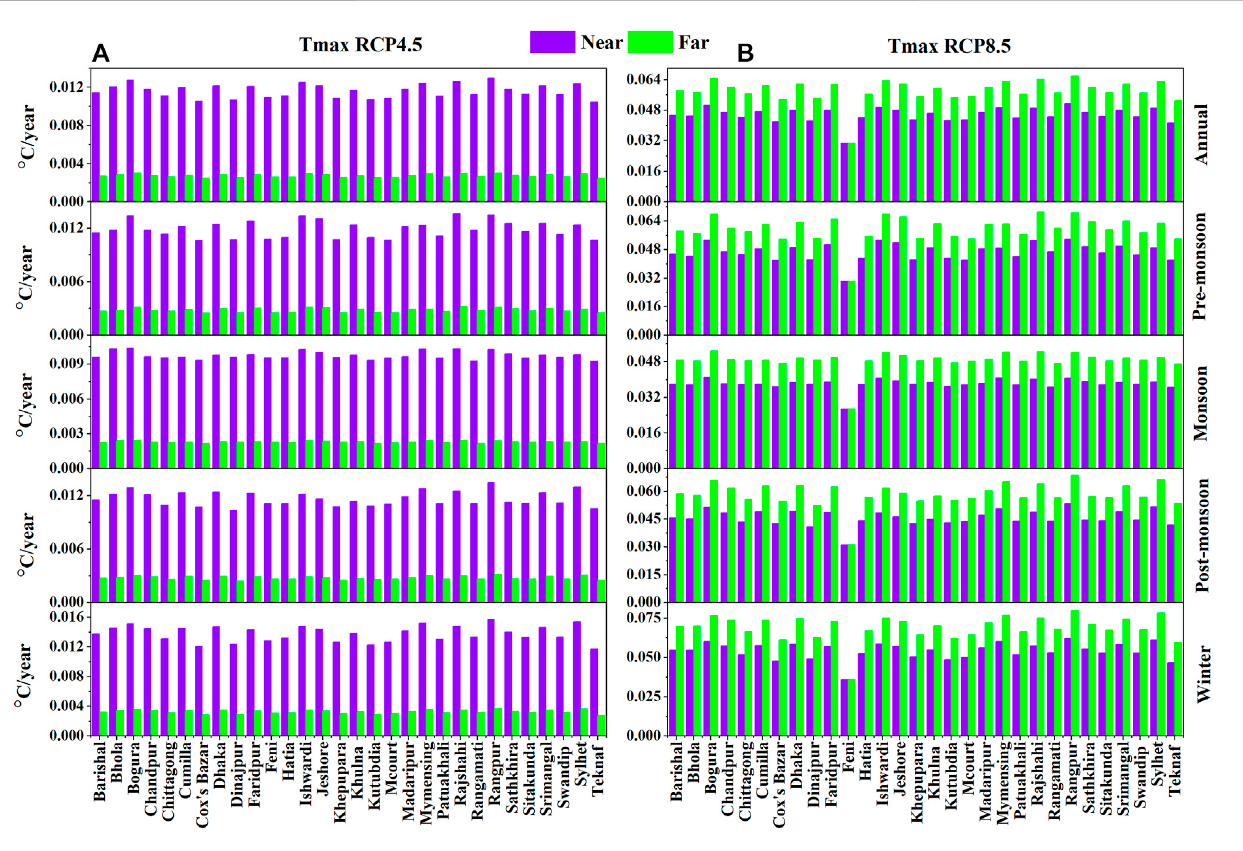
FIGURE 5 Sen ’ s slope estimator for annual and seasonal Tmax ( o C) trend (SS) analysis for near (2021 – 2060) and far (2061 – 2100) periods over Bangladesh considering 30 meteorological stations under (A) RCP4.5 and (B)